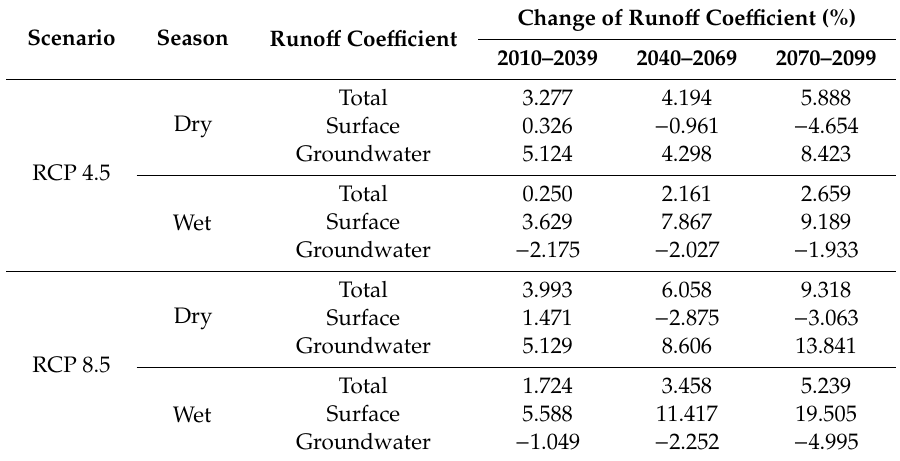
Table 7. Variation in the runo ff coe ffi cient and components in 3 future